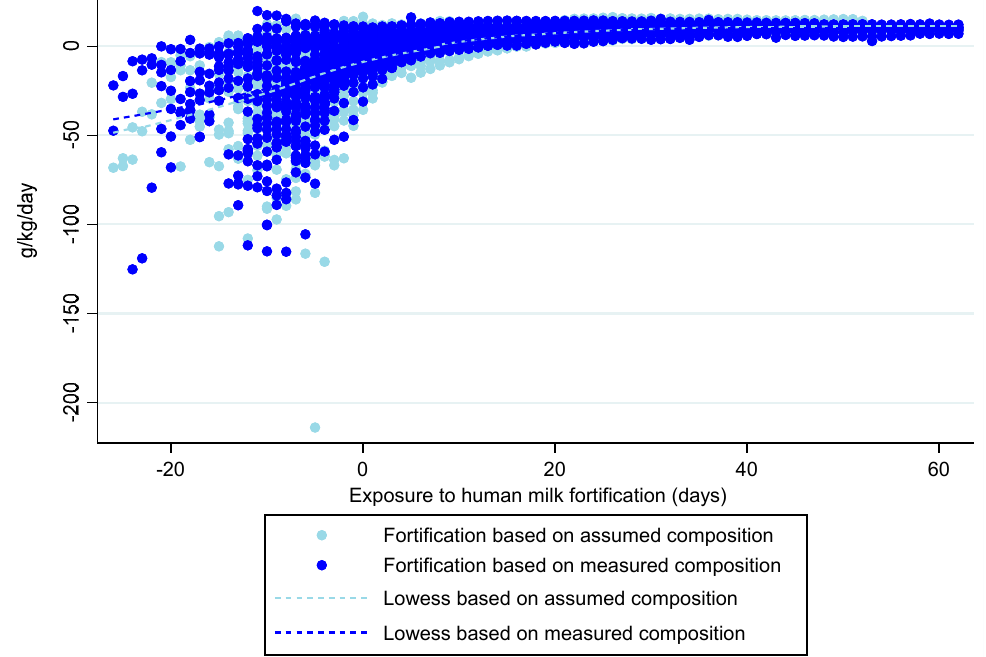
Figure 2. Weight gain velocity model in both groups, from birth to discharge, using a lowess smoother. Day ‘0’ indicates the starting day of exposure to human milk forti fi cation.